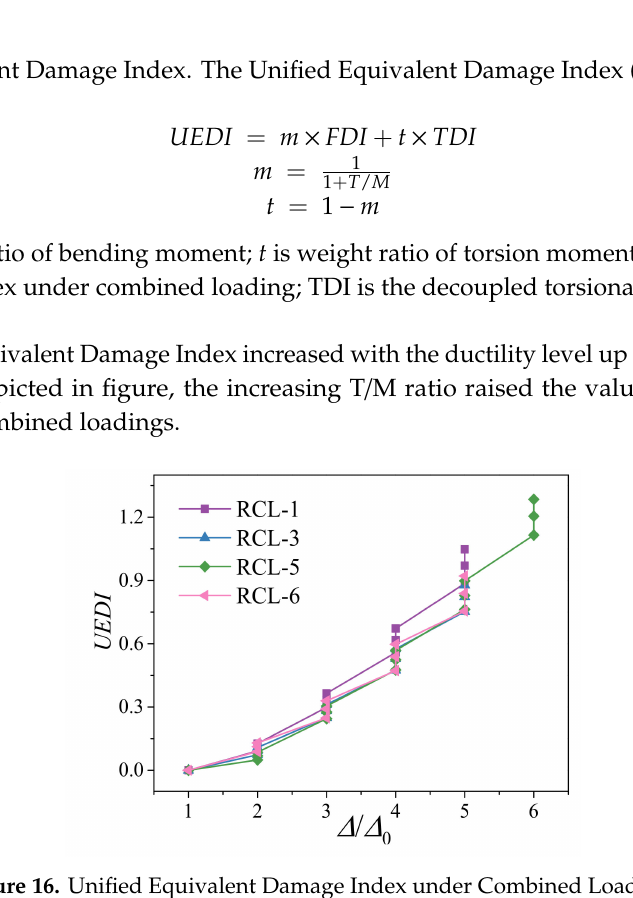
Figure 16. Unified Equivalent Damage Index under Combined Loadings.